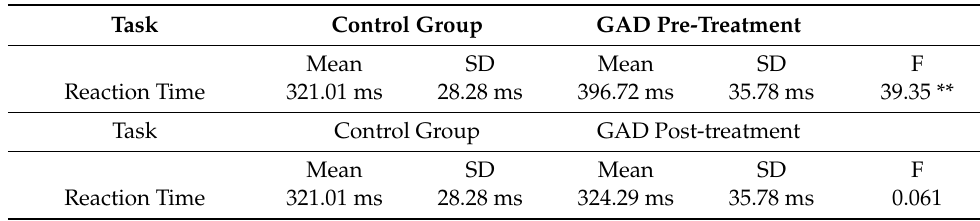
Table 2. Mean scores, standard deviations, significance, and effect size of children and adolescents that formed the control group, and children and adolescents with GAD pre- and post-treatment reaction time. Statistical significance was